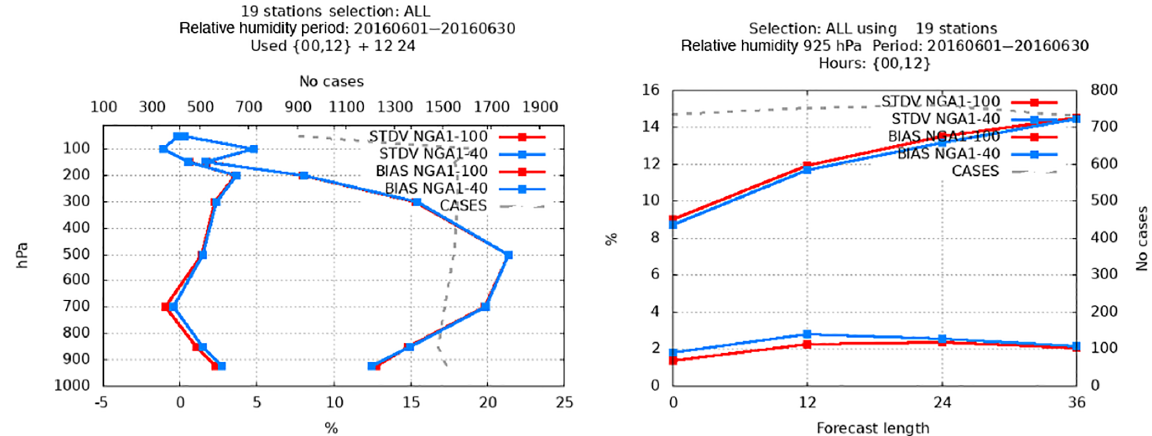
Figure 9. Bias and standard deviation of + 12 and + 24h relative humidity (unit: %) forecasts as a function of vertical level for verification against radiosonde observations. Scores are for experiments C1 (red) and C2 (blue).